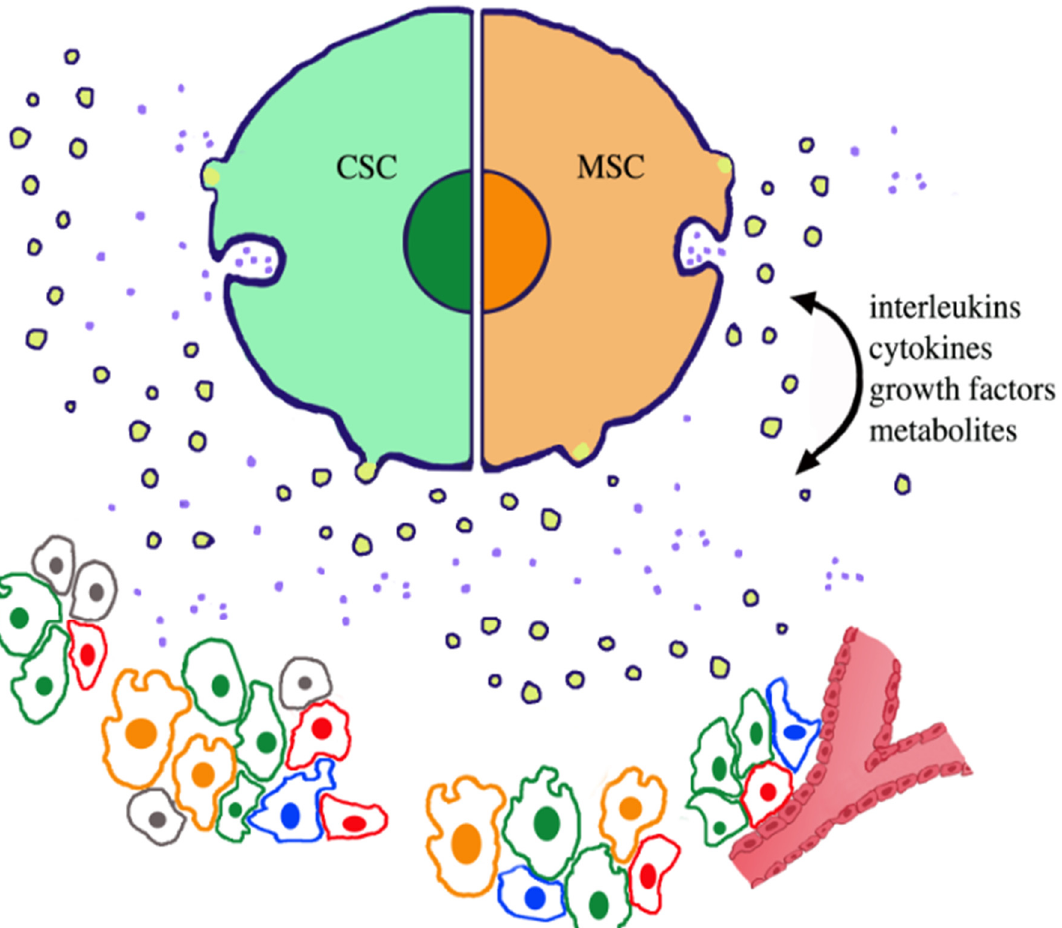
Figure 1. Various types of cells and their secreted vesicles that are present and active at cancer niches. At the top, two stem cells of a large size are shown attached to each other. Both the green cancer stem cells (CSC, left ) and the orange mesenchymal stem cells (MSC, right ) illustrate the secretion of two types of extracellular vesicles (EVs): small exosomes (light blue dots), diffusing out upon the exocytosis of their intracellular containers, the endocytic vacuoles multivesicular bodies (MVBs), and large ectosomes (membranes around yellow lumena), released by shedding of surface mini expansions. EV secretion occurs not only from the large-size cell images, but also from small cells distributed at the bottom, where, however, secretion is not shown. Secreted EVs navigate in the space among the cells. In the lower group, the cells with green and orange nuclei are CSCs and MSCs; cells with red nuclei are normal cancer cells; and cells with blue nuclei are non-cancer cells, for example immune cells that participate in cancer functions. Among their active functions, EVs mediate various types of paracrine and autocrine fusions, which are established with target cells of and outside the niches. Analogously, released fluid agents (interleukins, cytokines, growth factors) and